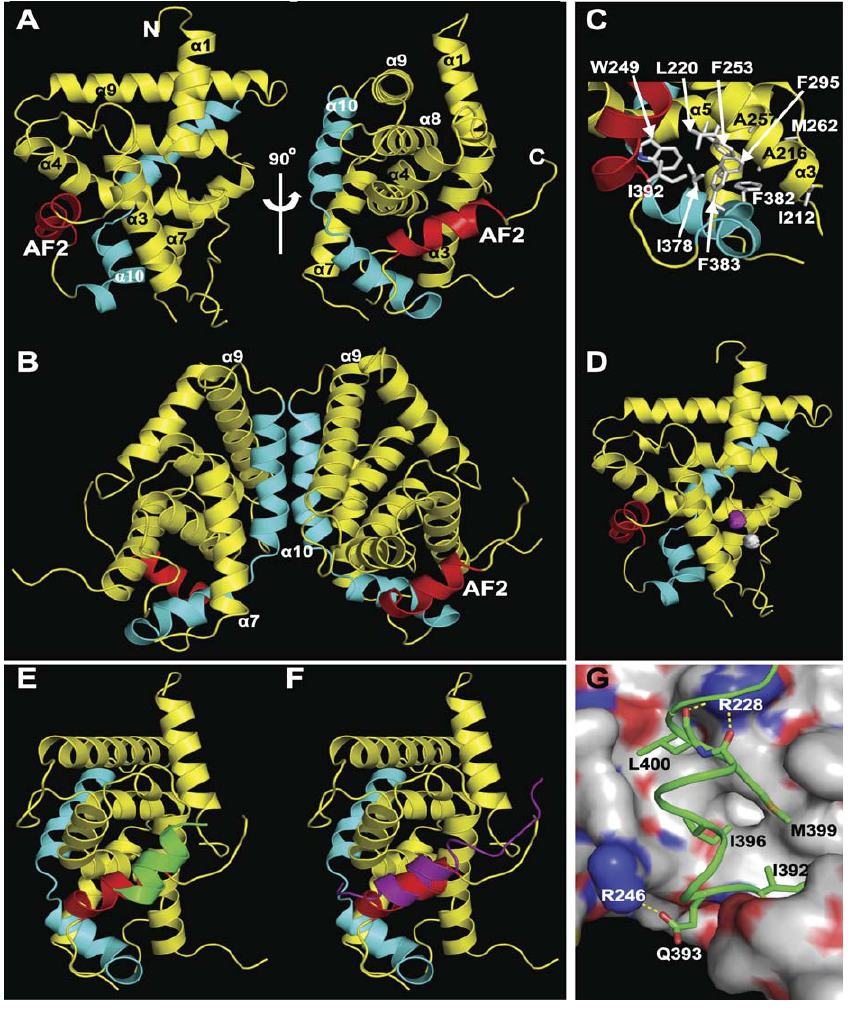
Figure 1. Crystal Structure of the Ligand-Free COUP-TFII LBD (A) Front and side views of the COUP-TFII LBD monomer with its AF2 helix colored in red. (B) Organization of the COUP-TFII LBD dimer, showing that its dimer interface is formed predominantly by helix a 10 (cyan). (C) The packing of the ligand-binding pocket within the bottom half of the COUP-TFII LBD. (D) Space-filling diagram shows two small cavities in COUP-TFII colored with magenta (18 A˚ 3 ) and white (12 A˚ 3 ). (E and F) Overlay of the COUP-TFII LBD structure with the SRC-1 LXXLL motif (green in E) from the RXR structure or with the SMRT corepressor motif (magenta in F) from the antagonist bound PPAR a structure. (G) Hydrogen bonds (yellow dashed lines) and hydrophobic interactions of the COUP-TFII AF2 helix (green) within the cofactor binding site.